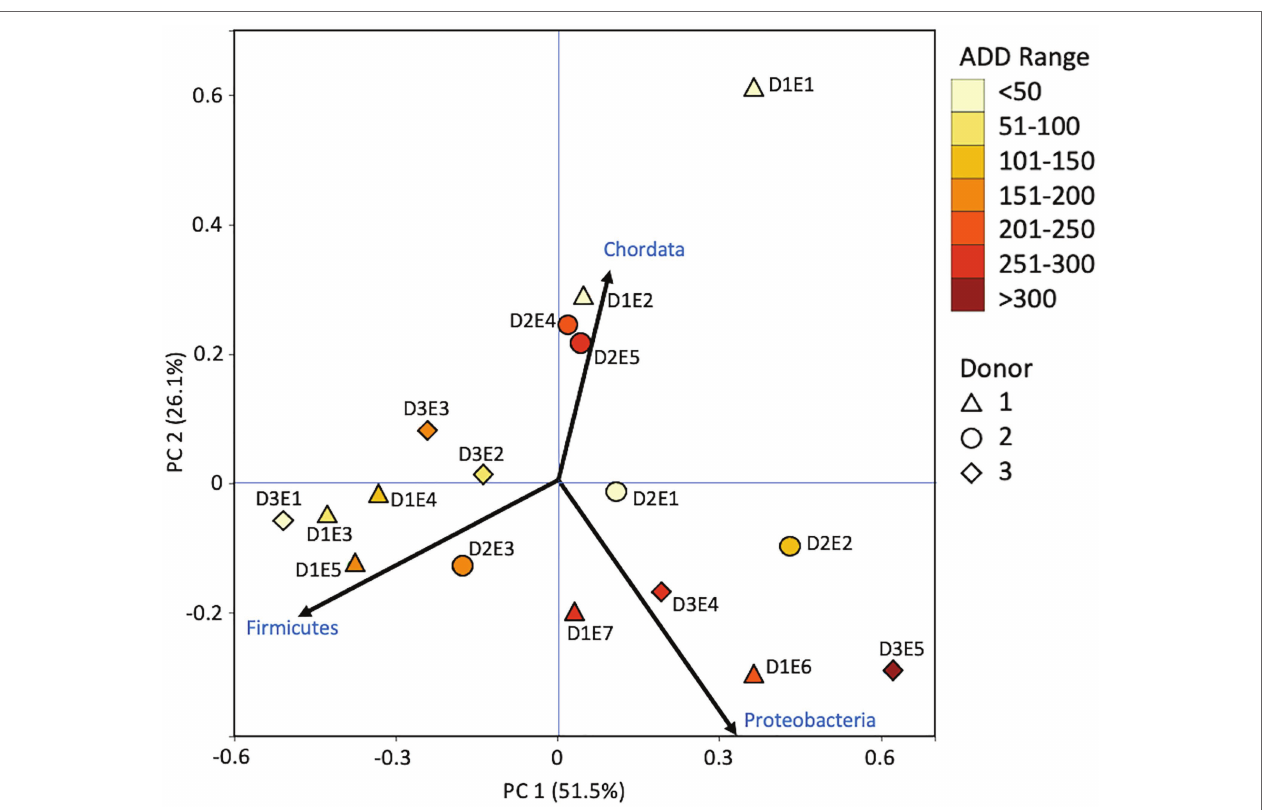
FIGURE 11 | Principal components analysis plot for the proportional data of bacterial and eukaryotic phyla observed from shotgun MetaT sequencing from oral samples of three human donors (Donors 1, 2, and 3) during decomposition. Shading is added to the symbols [triangles for Donor 1 (D1), circles for Donor 2 (D2), and diamonds for Donor 3 (D3)] to show earlier (lighter shading) to later (darker shading) ADD and also times sampled (from E1 to E7 for D1 and E1 to E5 for D2 and D3, indicating first sample to last sample